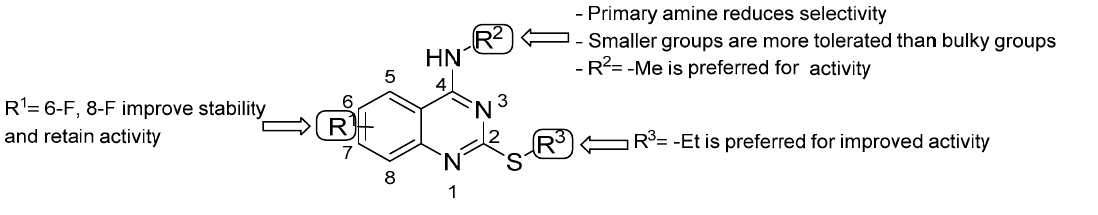
Figure 13. SARs of Figure 13. SARs of quinazolines. Figure 13. SARs of quinazolines.